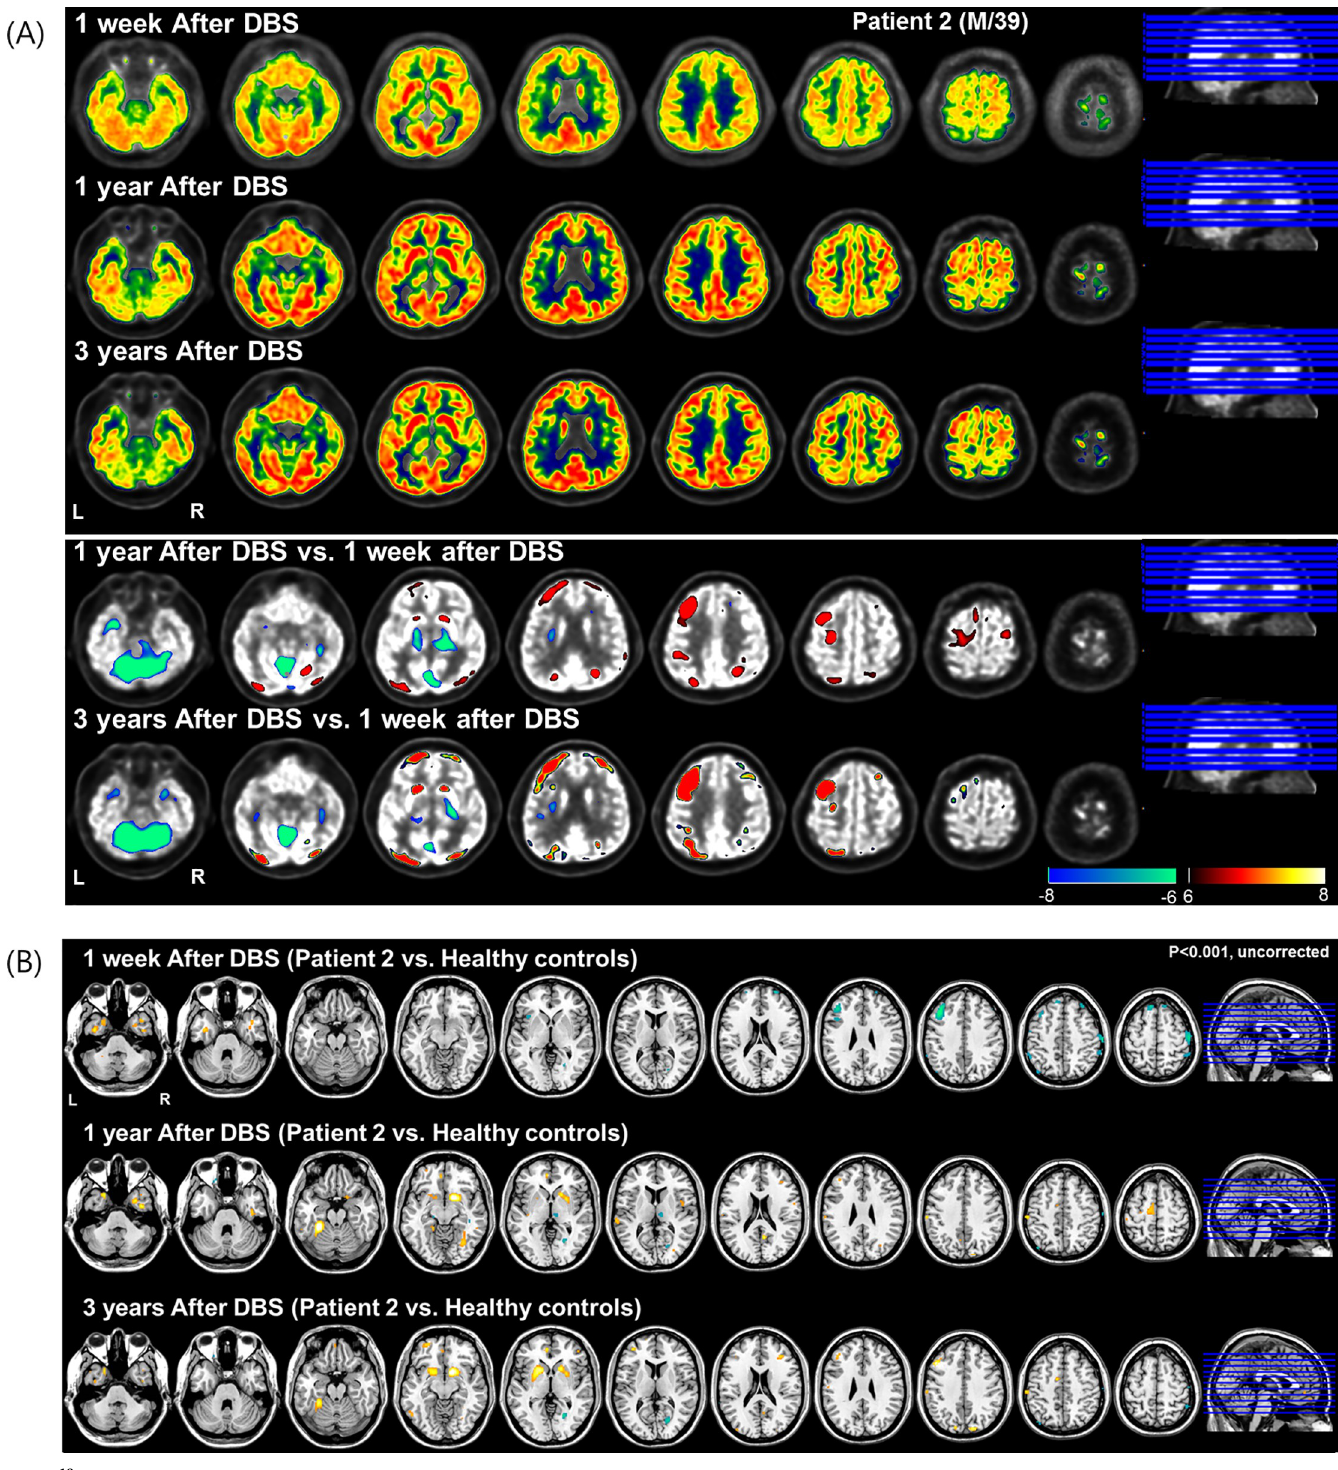
Fig 3. 18 Fluorodeoxyglucose-positron emission tomography (FDG-PET) taken in Subject two at postoperative 1 week, 1 year and 3 years. (A) FDG uptake in each period and subtraction map between pre-and post-operative state in two rows of bottom. The simple subtraction images of normalized FDG uptake between pre and post-operative state showed decreased (winter color map) and increased (hot color map) regional metabolic activity. (B) Relative to healthy controls (N = 24, mean age = 35.2 ± 8.6), the decreased metabolism at postoperative 1week was observed and increased metabolism in bilateral caudate and frontal regions at postoperative 1 year and 3 years was observed (p < 0.001, uncorrected for multiple